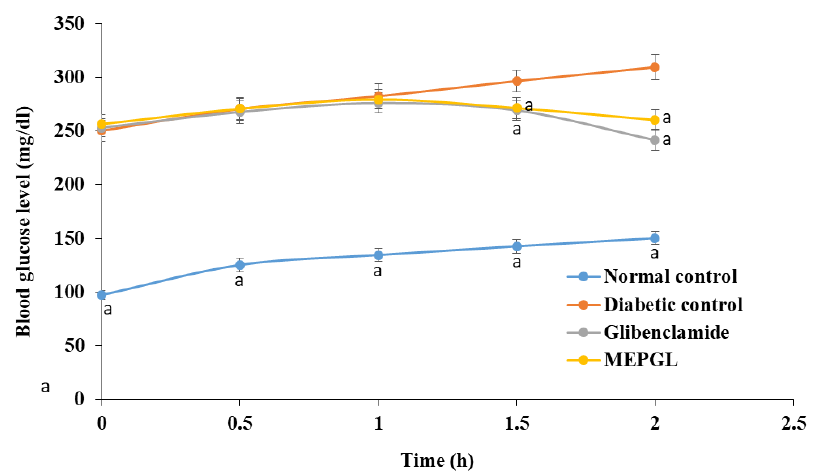
Figure 2. Effect of methanolic extract of Punica granatum leaves (600 mg/kg) on oral glucose tolerance test in nicotinamide/streptozotocin-induced type 2 diabetes in rats. Data are given as mean ± SEM ( n = 6). a Significant ( p < 0.05) difference compared to the diabetic group.